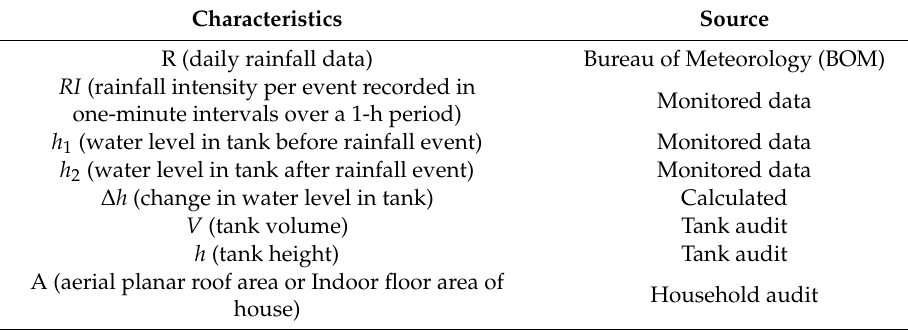
Table 2. Characteristics used to estimate effective roof catchment area.